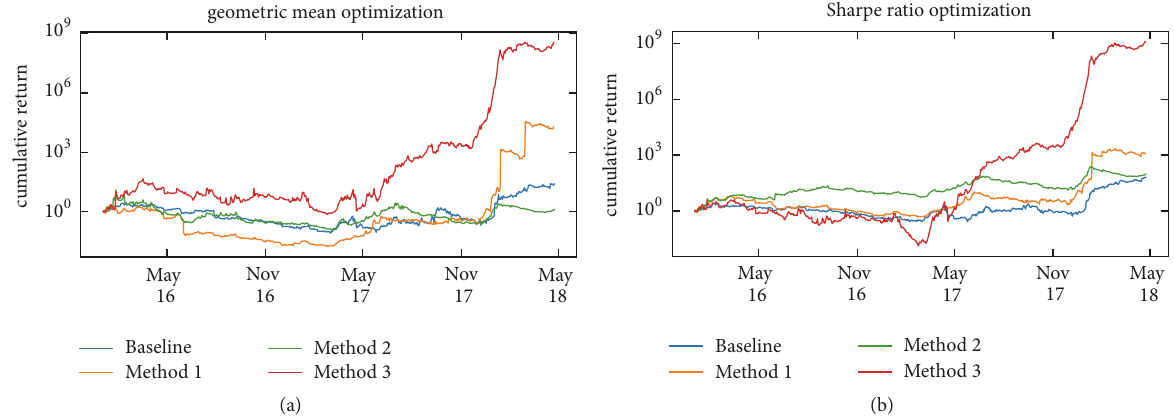
Figure5: Cumulativereturns. ThecumulativereturnsobtainedundertheSharperatiooptimisation(a)andthegeometricmeanoptimisation (b) for the baseline (blue line), Method 1 (orange line), Method 2 (green line), and Method 3 (red line). Analyses are performed considering prices in